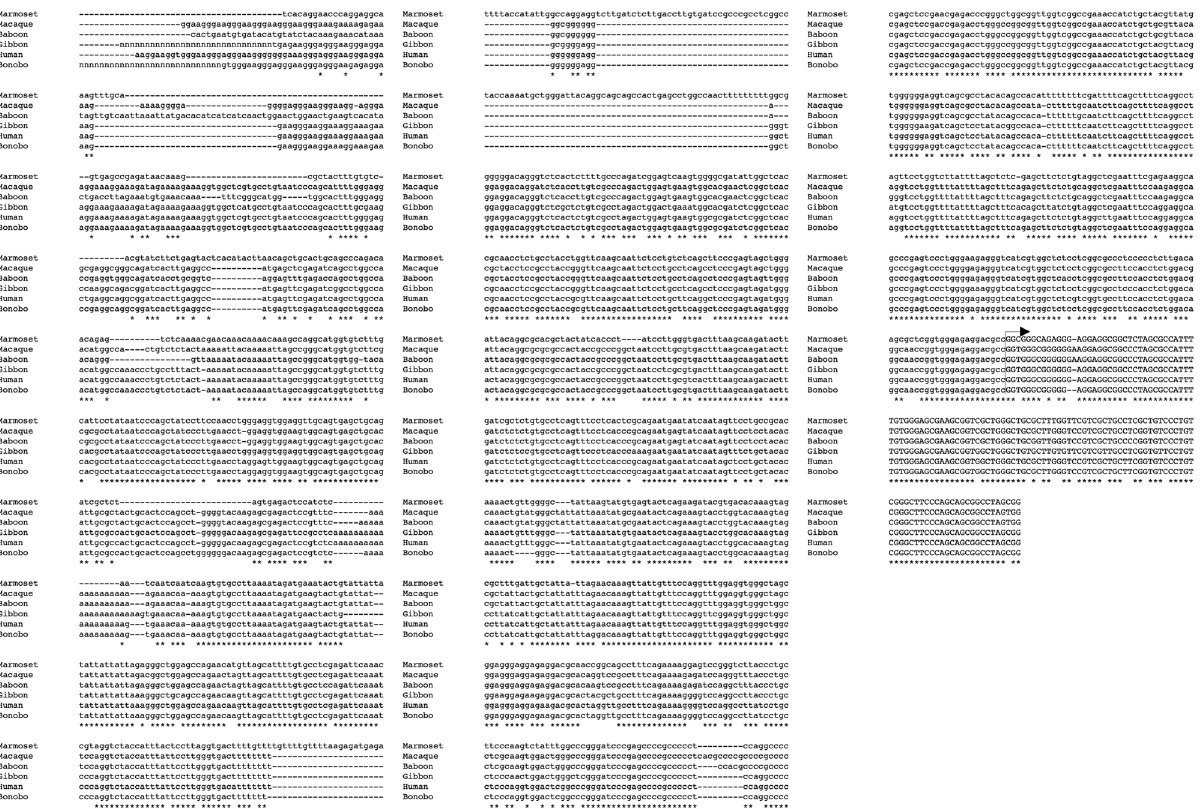
Figure 2. Genomic alignment of putative promoter regions from Homo sapiens, Pan troglodytes and Callithrix jacchus TARDBP genes. The alignment of the 1316nt—sequence upstream and 78 bp downstream of the transcription starting site of Human (Homo sapiens, ENSG00000120948, NM_007375.3) was carried out versus: Marmoset (Callithrix jacchus, ENSCJAG00000002381), Macaque (Macaca mulatta, ENSMMUG00000007456), Olive baboon (Papio anubis, ENSPANG00000017459), Gibbon (Nomascus leucogenys, ENSNLEG00000009512) and Bonobo (Pan paniscus, ENSPPAG00000039086) TARDBP transcripts, by using the MUSCLE alignment program (http:// www. ebi. ac. uk/ Tools/ muscle/ index. promoter motifs or with the main mapped TSS (DBTSS, http:// dbtss. hgc. jp, Fig. 1). In addition, a further analysis performed with another promoter search tool (GPMiner 56 ) failed to detect the main core promoter elements. These observations suggest that the expression of the human TARDBP gene is driven by a TATA-less promoter. Conservation of TARDBP promoter sequence throughout evolution. In order to study the evo- lutionary conservation of TARDBP promoter, the 1316 nucleotides upstream of the TSS of TARDBP tran- scripts from human and other species were retrieved using GenBank and Ensembl Genome Browser (http:// www. ensem bl. org/). Alignments were performed using MUSCLE software 57 . Among primates, we compared the genomic sequences of the putative TARDBP promoter region from Hominoidea ( Homo sapiens —Human, Pan paniscus —Bonobo, and Nomascus leucogenys —Gibbon), from of New World monkey ( Callithrix jacchus — Common marmoset) and from Old World monkey ( Macaca mulatta —Rhesus macaque; Papio anubis —Olive baboon). In general, this comparison highlighted that the relative degree of similarity among all three species increases significantly with respect to the proximity of the TSS. Then, in the region spanning from nucleotide -1316 to -1000 upstream from TSS, the hominoid sequences seem to be closer to each other than with that of New and Old World monkeys. On the other hand, in the region spanning the 1000 nucleotides upstream from TSS, the sequences from all primates show a high degree of identity (Fig. 2). On the other hand, the alignment of the human, mouse and rat putative TARDBP promoter sequences shows a low degree of global similarity (Fig. 3A). Nevertheless, the region of the rodent gene promoters spanning approximately 500nt upstream from the TSS shows a higher level of similarity, suggesting that proximal region of the putative TARDBP promoter region might encompass regulatory elements conserved across primates and rodents. In fact, pairwise sequence alignment between the 1316nt-sequence upstream of TSS of the human/mouse and human/rat TARDBP orthol- ogous genes outlined a 62%/63% of local similarity/identity (with 8% and 5% gaps, respectively) between the sequences of the two species, in 300/500nt-region upstream of the respective TSSs (Fig. 3B). In consideration of the observations pinpointing how age regulated variations in TDP-43 expression seem to be evolutionary conserved at least in mouse and fly 58,59 , we tried to perform pairwise sequence alignment between the 1316nt- sequence upstream of TSS of the mouse and fruit fly TARDBP ortholog genes. The local alignment of two the